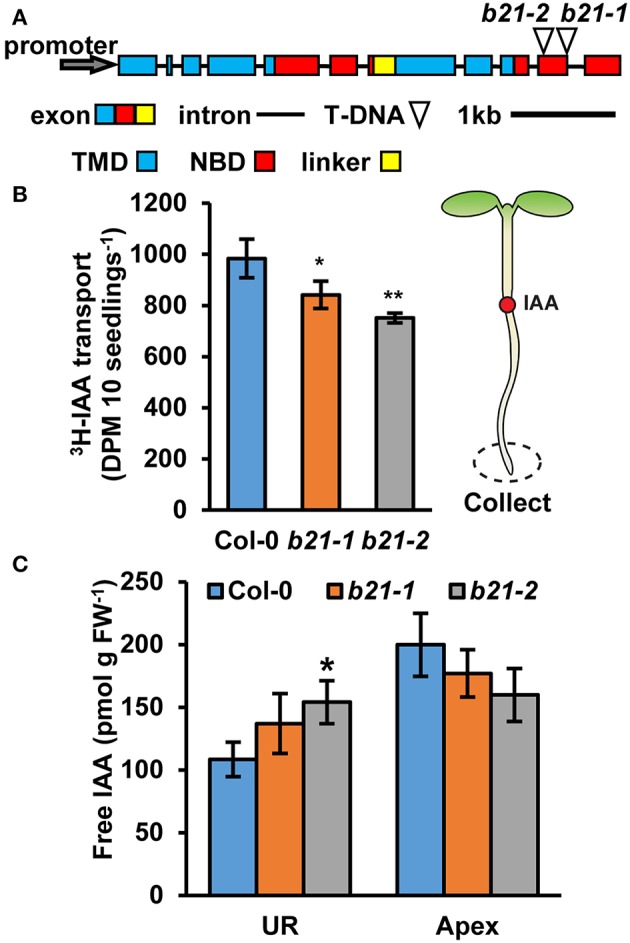
Auxin transport and levels in abcb21 roots. abcb21 mutants exhibit reduced acropetal auxin transport in roots. (A)
ABCB21 gene model indicating T-DNA insertion positions for abcb21-1 (WiscDsLox1C2) and abcb21-2 (Gabi_954H06). Boxes correspond to exons with approximate positions of transmembrane domains (TMD; blue), nucleotide-binding domains (NBD; red), and linker region (yellow). (B) [3H]IAA transport from the root-shoot transition zone to the root tip in 5.5 d seedlings. Data shown are means ± SD (n = 3 pools of 10). (C) Quantification of free IAA levels in 5.5 d light grown seedlings. UR, upper root; Apex, apical 2 mm root section. Data shown are means ± SD (n = 3 pools of 10). Asterisks indicate statistical difference from Col-0 by Student's t-test for * P < 0.05 and ** P < 0.01.